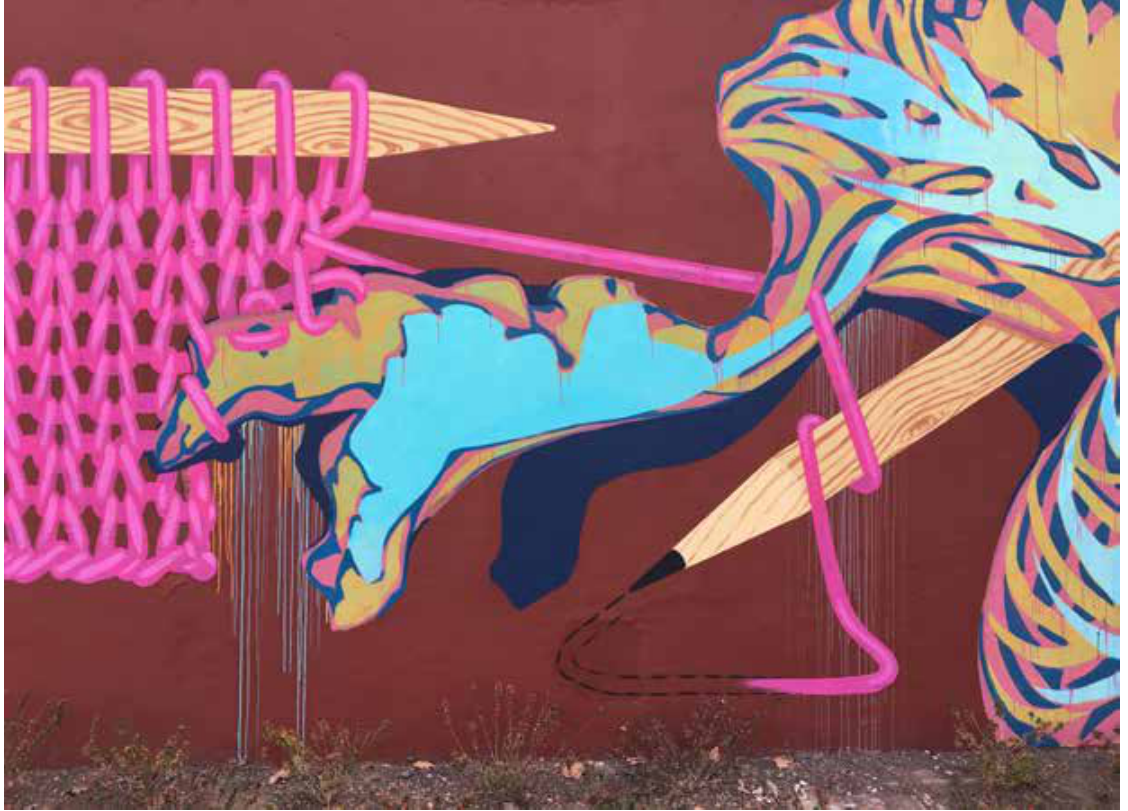
Figure 3 (opposite): Many marchers wore Pink Pussy Hats, Women’s March on Washington (January 21, 2017). Source: Shari Kerrigan.